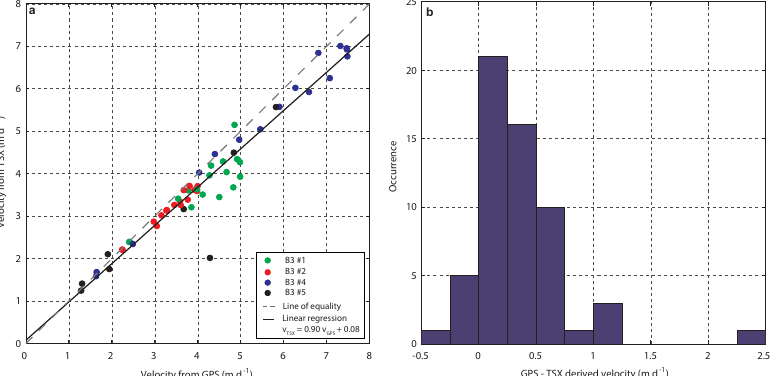
Figure A2. Comparison of TSX and GPS velocities at GPS locations and for each repeat-pass period. (a) Linear regression (solid black; R 2 = 0 . 94) predicts 94% of the variance in TSX velocities (0.14md − 1 ). (b) TSX velocities typically slightly underestimate local (sub-pixel- scale) velocities measured at the GPS stations by 0.3md − 1